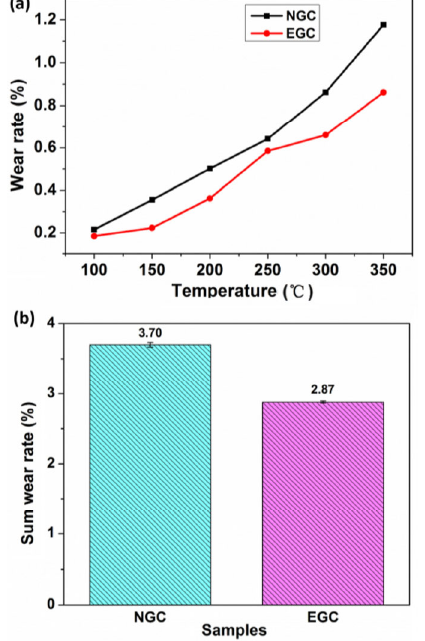
Fig. 7 Effect of graphites with different microstructures on the wear rate of the friction materials: (a) wear rates at different temperatures and (b) the total wear rate.